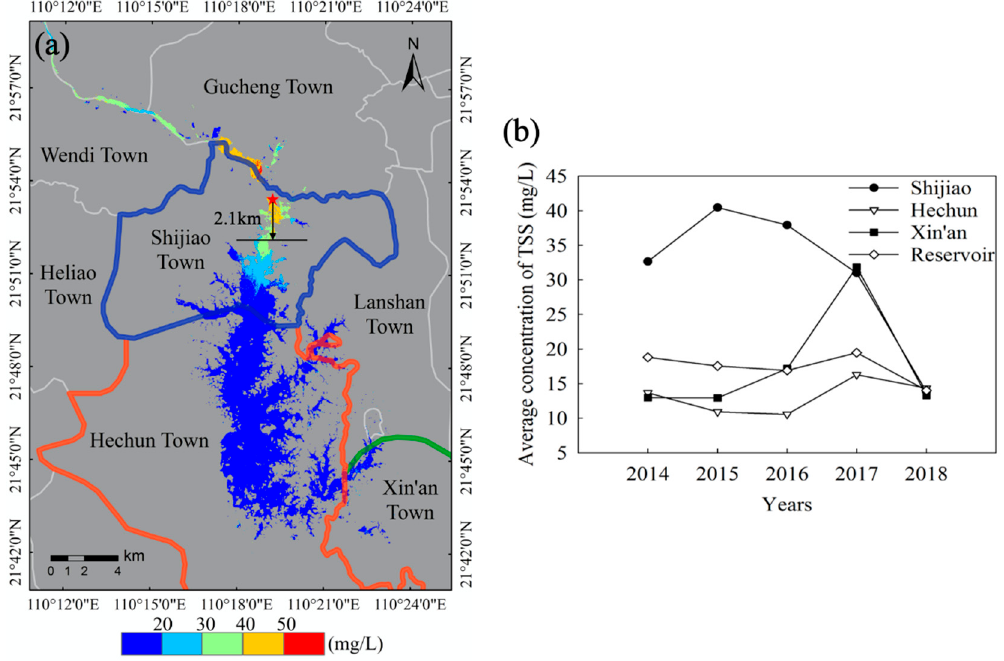
Figure 5. The spatial distribution of TSS concentration based on OLI imagery in Hedi Reservoir, where di ff erent colored lines represent di ff erent boundaries of towns: ( a ) mapping of the averaged TSS concentration in Hedi Reservoir from 2014 to 2018, and ( b ) the comparison of the annual average TSS concentration in di ff erent areas within the reservoir. The color scale is the legend of the average TSS concentrations, in mg / L. The location of the red star in the picture is the government of Shijiao Town.